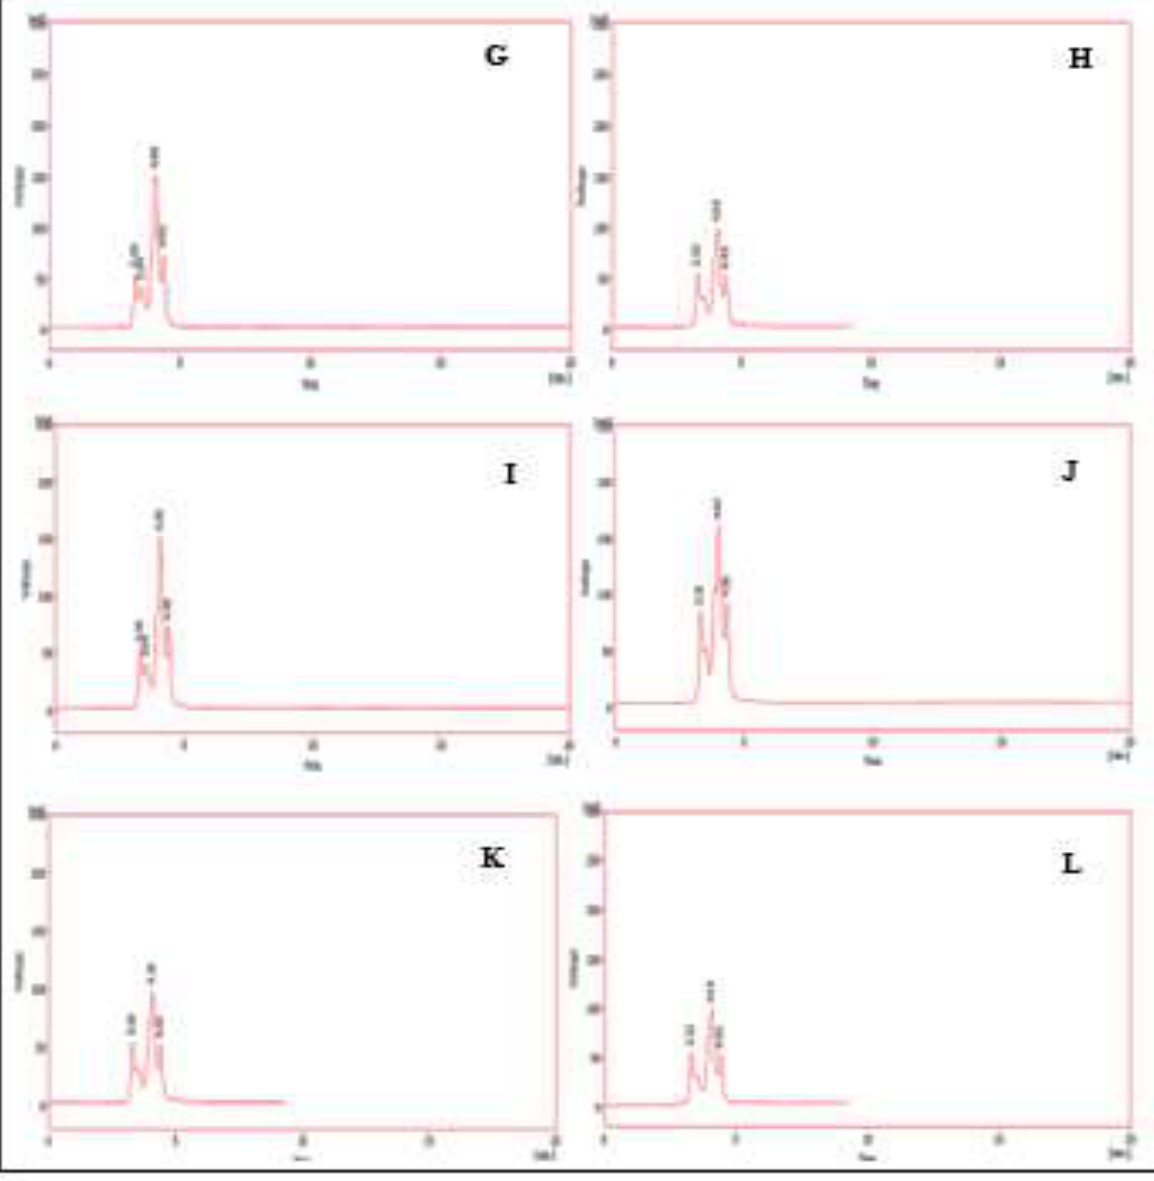
Figure 9. HPLC chromatogram of ethyl acetate fraction of G: DBA, H: MBA, I: DBAE, J: MBAE, K: DBE, L: MBE